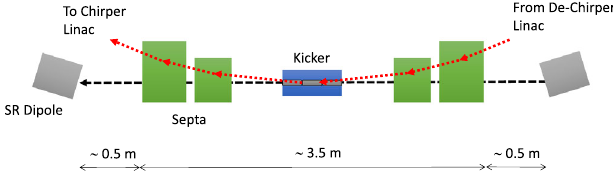
FIG. 9. Top-view (not to scale) of a fast stripline kicker system in between septum magnets, for on axis swap-out injection into the SRLS (beam travels from right to left), and for extraction from the SRLS at successive